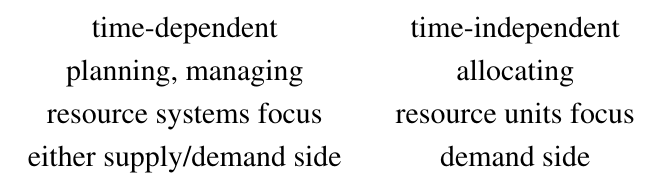
Table 4. Challenges in management of resource